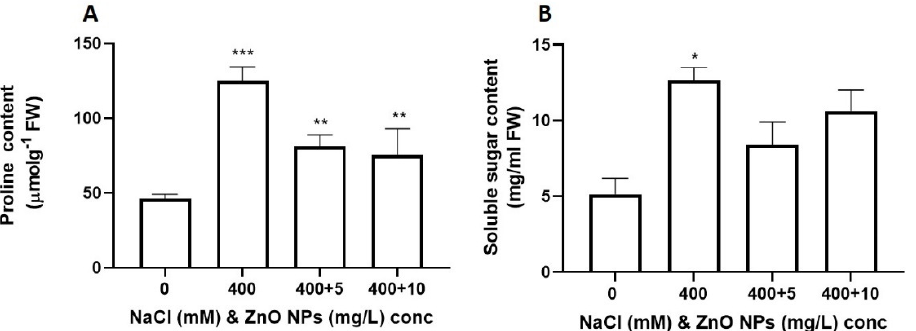
Figure 7. Effect of salt and ZnO NPs on osmolyte accumulation in sorghum. ( A ) Proline content and ( B ) soluble sugars in salt-treated plants and those primed with ZnO NPs. Error bars represent the SD calculated from three biological replicates. Statistical significance between control and treated plants was determined by a two-way ANOVA performed on GraphPad 9.2.0, shown as *** = p ≤ 0.001 ** = p ≤ 0.01, and * = p ≤ 0.05 according to the Bonferroni’s multiple comparisons test.